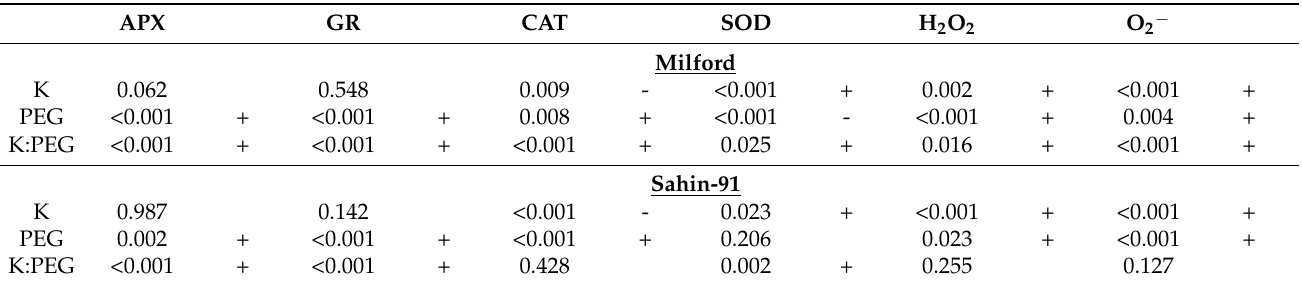
Table 3. Response of antioxidant activities (APX, GR, CAT, SOD) and ROS concentrations (H 2 O 2 , O 2 − ) to K, PEG and K:PEG. p -values of Kruskal–Wallis tests are shown. “+” for K, PEG and K:PEG indicates the following: (K) a significant increase in the respective trait from adequate (0.8 mM K + ) to low (0.04 mM K + ) K supply; (PEG) a significant increase in a trait from − PEG to +PEG under adequate K supply; (K:PEG) a significant increase in a trait from − PEG to +PEG under low-K supply. “-“ indicates a significant decrease in the above-mentioned traits. Statistics were performed on fully expanded young leaves samples taken between 11 and 19 DAO ( n =